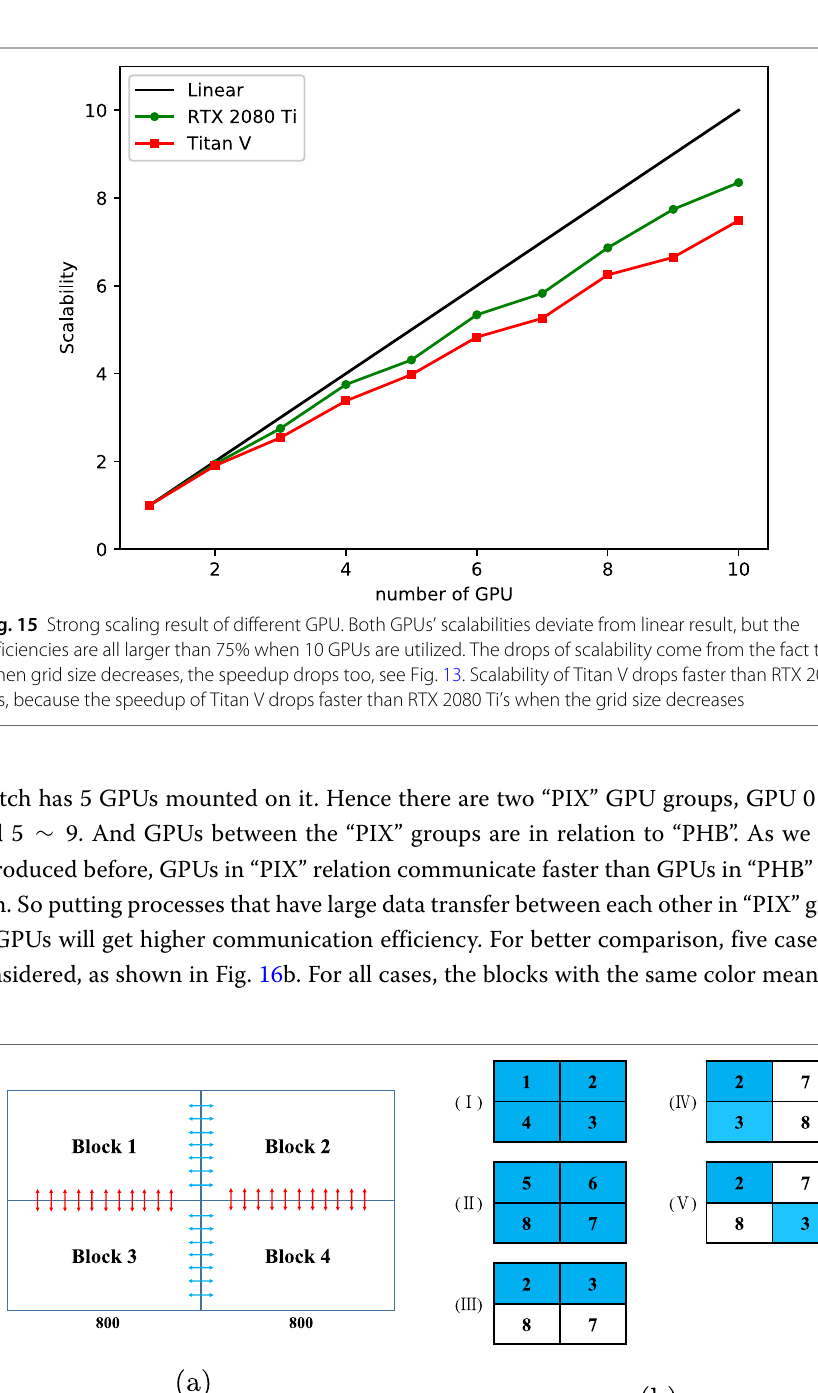
Fig. 16 Cases configuration. In figure ( a ), there are 100 points in the spanwise direction. Data exchange in vertical direction (red) is larger than data exchange in horizontal direction (blue). In figure ( b ), five cases are set to test the communication performance of different strategies of computations assigned to different GPUs. The number in block presents the GPU ID in which computation is performed. Blocks with the same color indicate that they are in the same PCIe switch. In cases I and II, computations are performed on GPUs that are in two different PCIe switches respectively. In cases III to IV, computations are performed on GPUs belonging to both two PCIe switches. For case III, the maximum data transfers are performed across the PCIe switch. In case IV, the maximum data transfers are performed within the same PCIe switch. In case V, all data transfers are performed across the PCIe